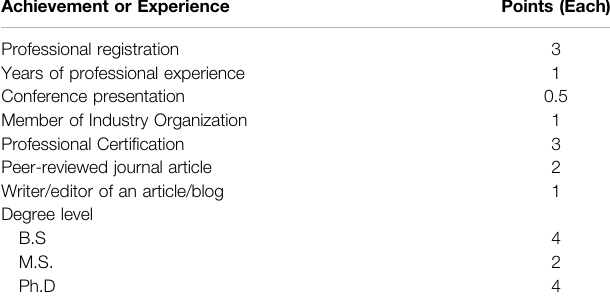
TABLE 2 | Expert Evaluation System. Achievement or Experience Points